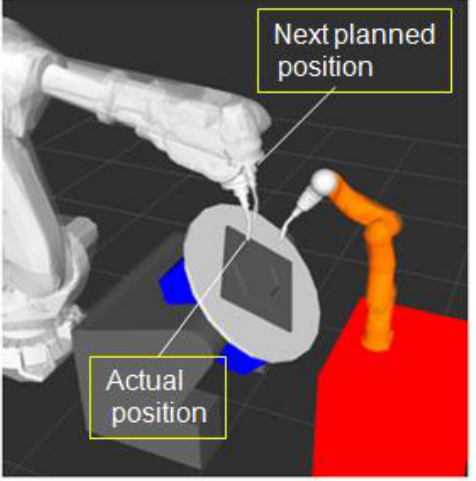
Figure 17. Motion planning with real and “shadowed“ robots for detailed evaluation of the planning process.